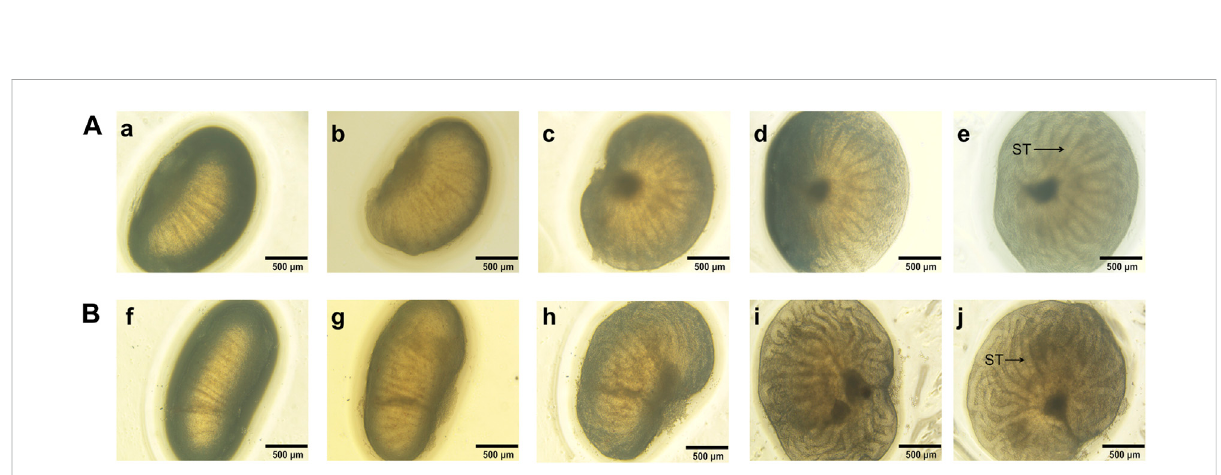
FIGURE 2 Microscopic views of 15.5 dpc fetal testis cultured for 4 days a, f: d0; b, g: d1; c, h: d2; d, i: d3; e, j: d4. The seminiferous tubules were fi rstly observed on d2 in the modi fi ed group and the length and thickness of seminiferous tubules apparently increased. By contrast, the seminiferous tubules were fi rstly seen on d4 in control group, the seminiferous tubules were more coiled in modi fi ed group compared to control on d4. ST, seminiferous tubules. (A) : control group, (B) : the modi fi ed group. ×40 magni fi cation. Scale bars indicate 500 µm.